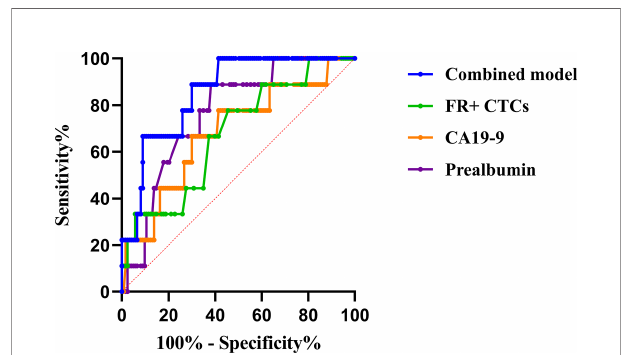
FIGURE 3 | The ROC curve of potential risk factors and combined model for peritoneal metastasis. * ROC, receiver operating characteristic; FR+CTCs, folate receptor-positive circulating tumor cells; CA19-9, carbohydrate antigen 19-9.